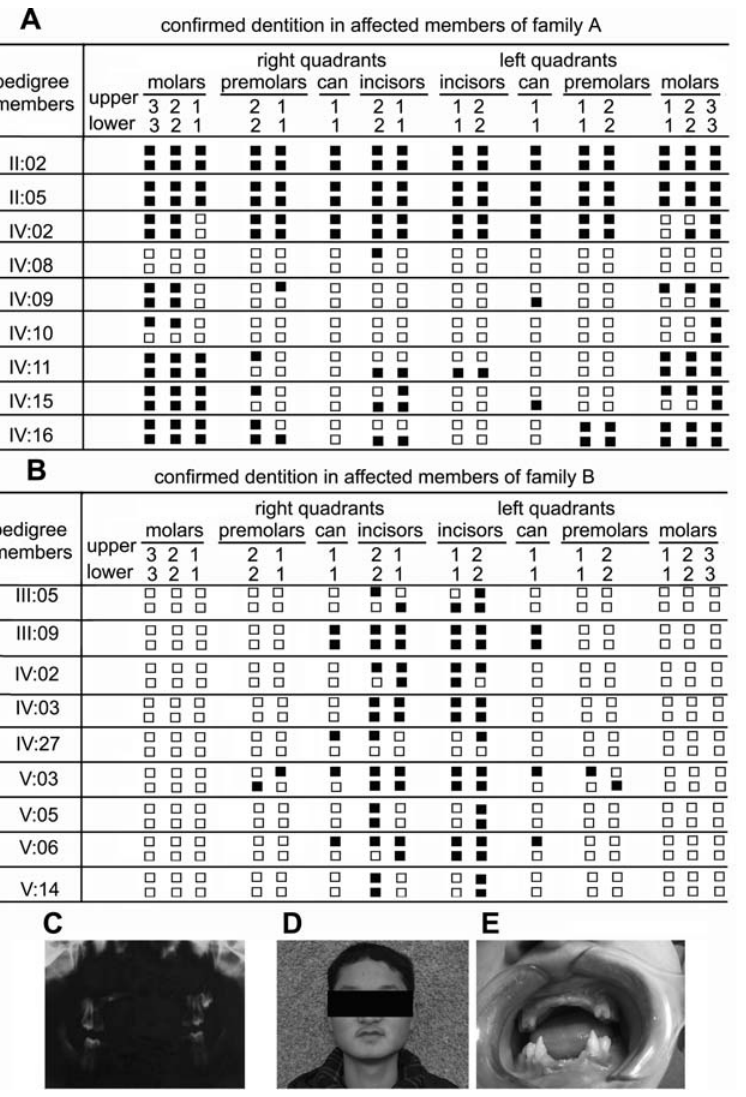
Figure 2. Clinical evaluations. (A) and (B). Synopsis of the permanent dentition in affected members of Family A and Family B. Closed squares represent absent teeth. (C). Panoramic radiograph of a proband (IV:02) in Family A at age 14. He had up left permanent second molar, four permanent first molars and four milk second molars. (D) and (E): Clinical appearance of V:03 (Family B), at age 18, showing absence of all the incisors, two up cans and four premolars.